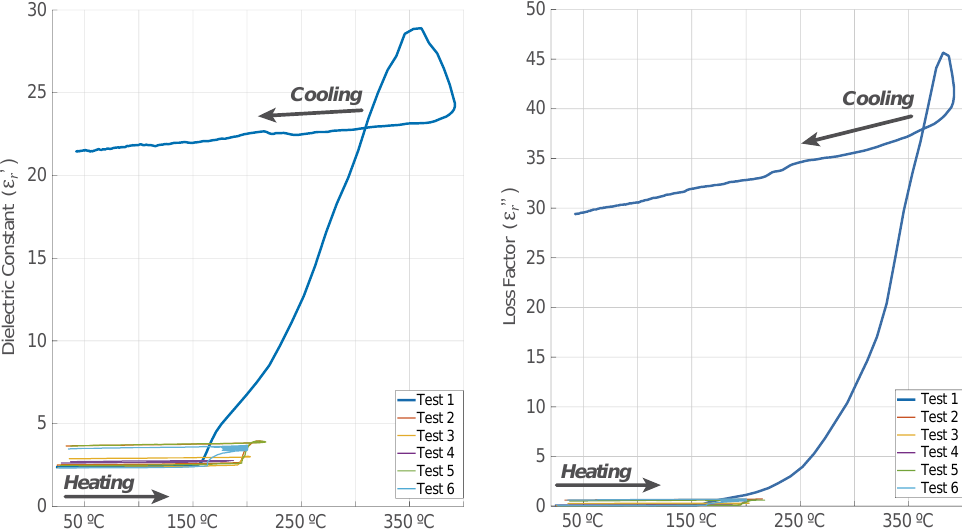
Figure 4. Relative electric permittivity behavior versus temperature for each test.